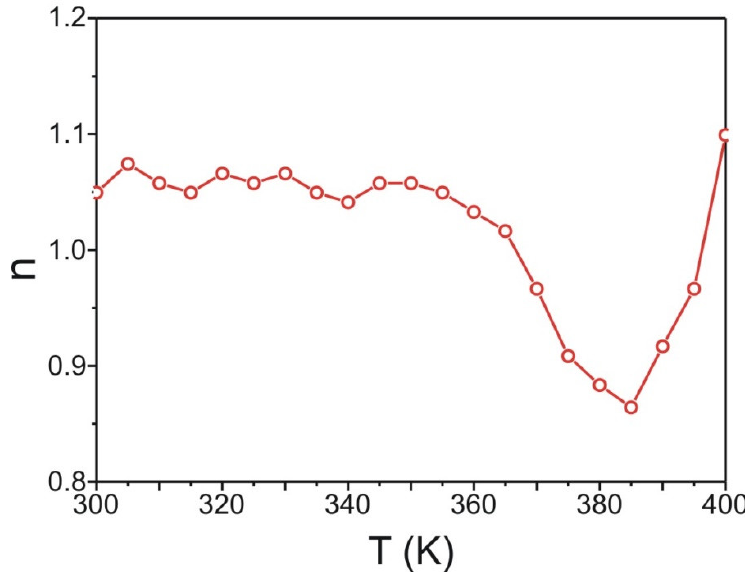
Figure 7. The temperature dependence of the exponent n for studied material.